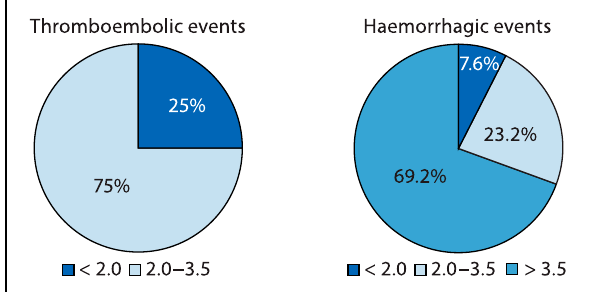
Figure 2: The occurrence of thromboembolic and haemorrhagic